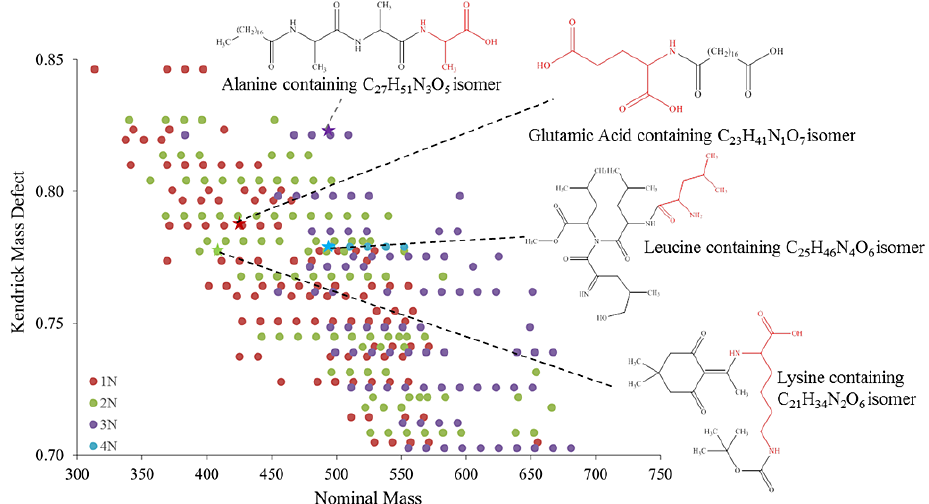
Figure 7. Kendrick mass defect series (CH 2 ) for CHON formulas containing 1–4 nitrogen atoms identified for samples N Am 6 and N Am 7 which make up the Primary Marine sample group. The molecular structures represent potential amino acid containing isomer compounds corresponding to several identified molecular formulas. The red portions of the molecular structures represent the amino acid portions of the compounds. Table 1. PCA group magnitude-weighted average elemental formula characteristics and elemental formula percent compositions. PCA group O/C H/C AI mod CHO CHON CHOS CHONS CHOP CHONP CHOSP Primary Marine 0.32 1.66 0.09 North American-influenced 0.50 North African-influenced 0.45